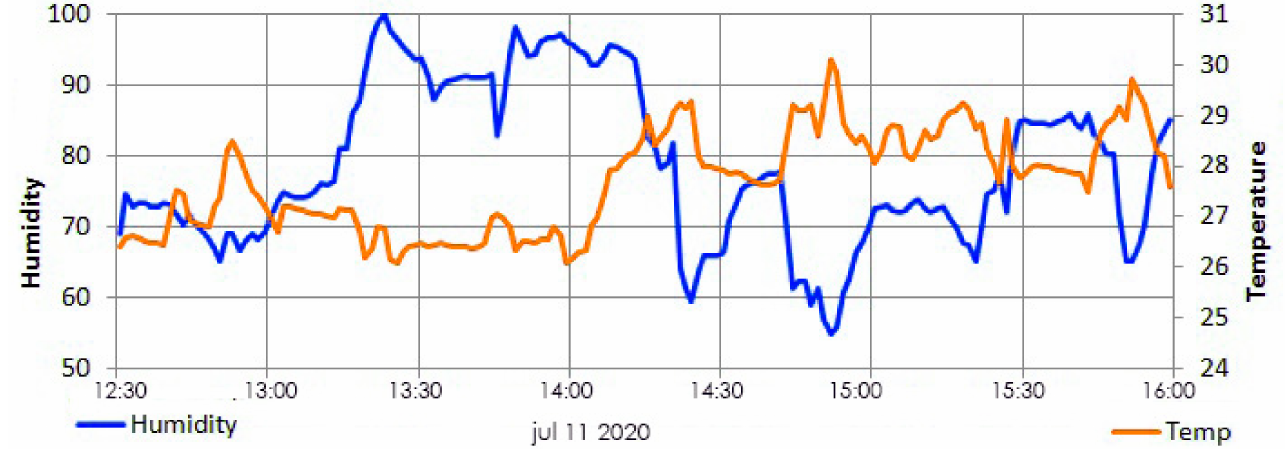
Figure 15. Temperature and humidity relation.